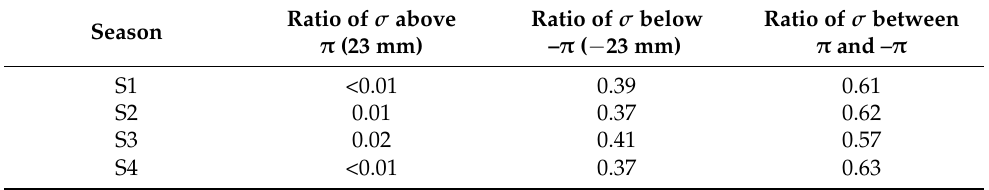
Table 6. σ values within error range—WRF vs. GNSS ZTDs average of all stations.